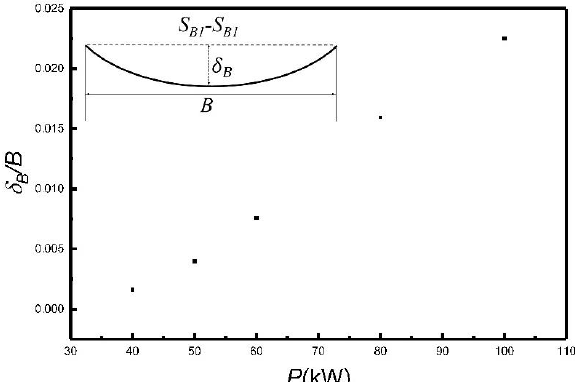
Figure 15. Bending deflection of the S B 1 -S B 1 section for different input powers.